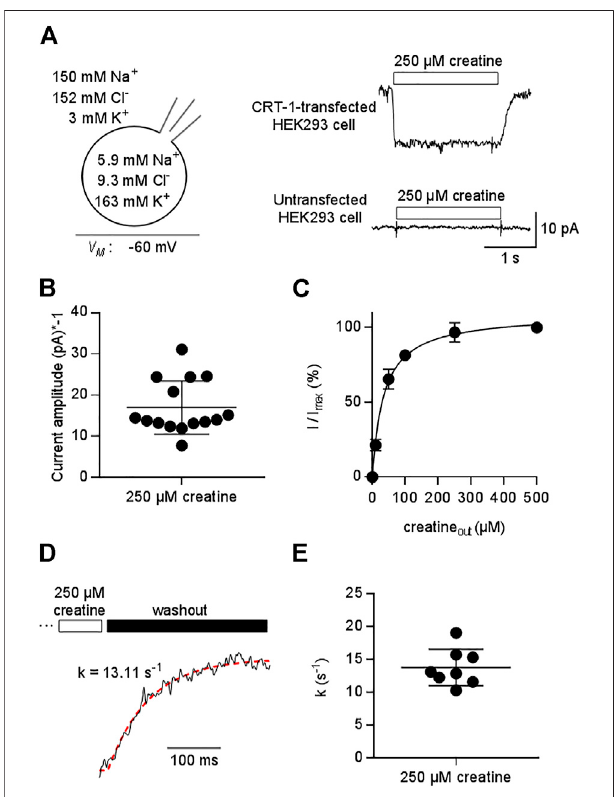
FIGURE 1 | Patch clamp-recordings of creatine-induced currents through CRT-1 expressed in HEK293 cells. (A) The schematic representation on the left hand side illustrates the recording condition, i.e. the membrane potential, the extracellular and the intracellular ion concentrations employed in panels (A – E) . Right hand side: Representative current traces elicitedby250 µMcreatineinatransientlytransfectedHEK293cellexpressing human CRT-1 (top) and in an untransfected cell (bottom). (B) Amplitude of CRT-1 mediated currents elicited by creatine: recordings were done as in panelAin15individualHEK293cellstransientlyexpressinghumanCRT-1. (C) Concentration-dependent increase in current amplitude through CRT-1 evoked by extracellular creatine (250 µM): recordings were done as in panel A with HEK293 cells transiently expressing CRT-1. For each cell, currents (I) were normalized to the current obtained with 500 µM creatine (I max ) to correct for variable amplitude (see panel B). Data are means ± S.D. from 12 individual cells. The solid line was drawn by fi tting the data to the equation for a rectangular hyperbola, which yielded an EC 50 of 34.8 ± 1.9 µM. (D) Representative trace illustrating the deactivation of the substrate-induced current:thecurrentthroughCRT-1waselicitedby250 µMcreatineasinpanel A. Only the current decay is shown, which was evoked by solution exchange and by the thus resulting washout of creatine. The red dashed line was drawn by subjecting the data points to the equation for a mono-exponential decay. The rate constant k (13 s − 1 ) extracted from the fi tted curve provides an estimate for the turnover rate of CRT-1. (E) The rate constants of current decay were determined as illustrated in panel D from the recordings of 8 individual cells, the current amplitude of which are shown in panel